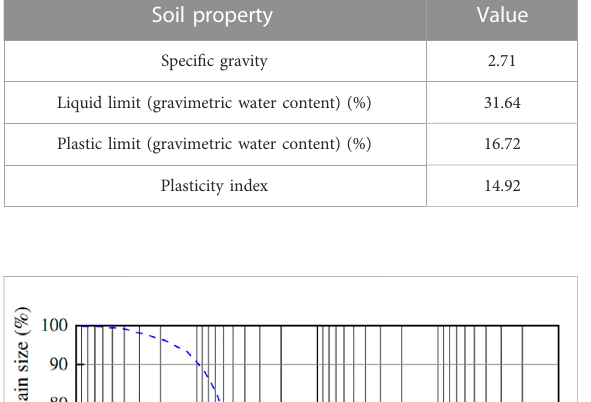
TABLE 2 Main chemical compositions of the Portland cement used in the